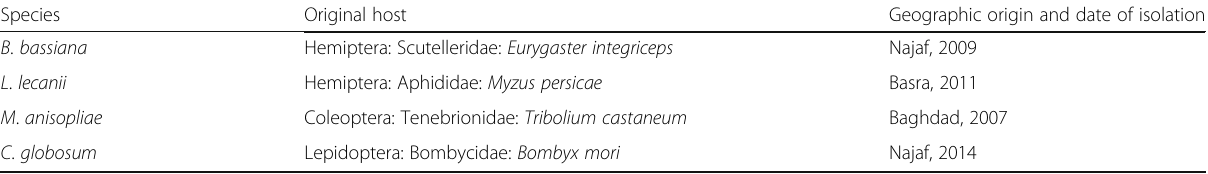
Table 1 Original host and geographical origin of Iraqi entomopathogenic fungi used in this study Species Original